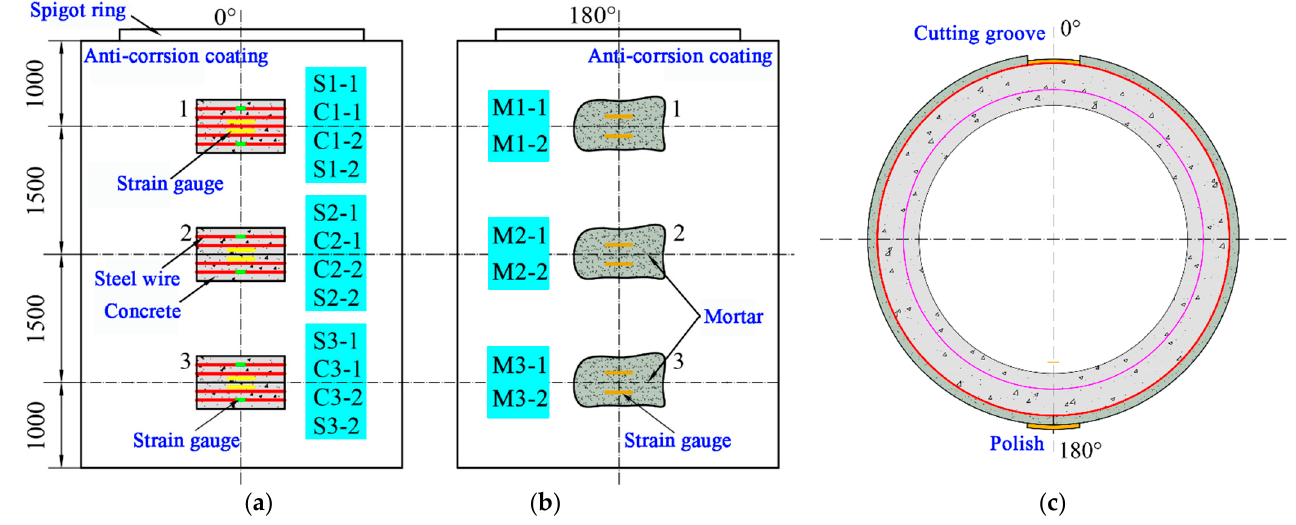
Figure 3. Monitoring arrangement (unit: mm): ( a ) zones for concrete and steel wire; ( b ) zones for mortar; ( c ) locations at cross section.